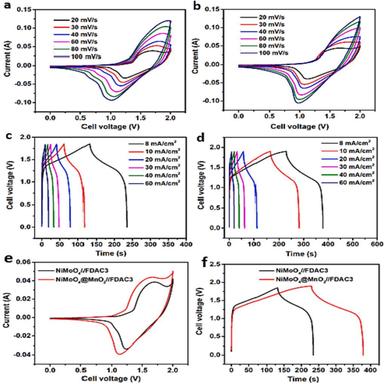
Electrochemical performances of the two different flexible All-Solid-State ASC cell devices. CV curves of NiMoO4//FDAC3 (a) and NiMoO4@MnO2//FDAC3 (b), GCD curves of NiMoO4//FDAC3 (c) and NiMoO4@MnO2//FDAC3 (d), CV curves of the two different ASCs at the same scan rate of 20 mV/s (e) and the GCD curves at the constant current density of 8 mA/cm2 (f).